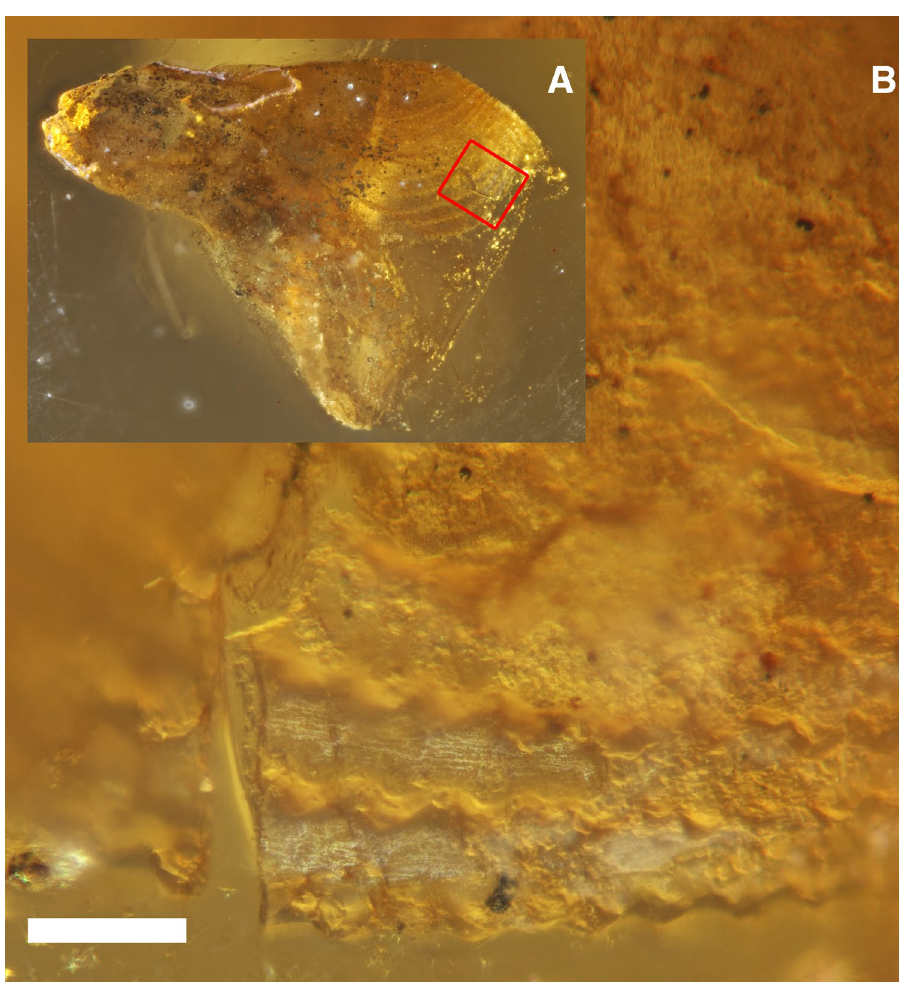
Figure 5. Rasping surface of † Palaeolignopholas kachinensis gen. & sp. nov. shell. ( A ) Holotype shell. The red frame marks position of the enlarged area. ( B ) Undulated micro-sculpture of the rasping surface. Scale bar = 100 µm. (Photos: Ilya V.